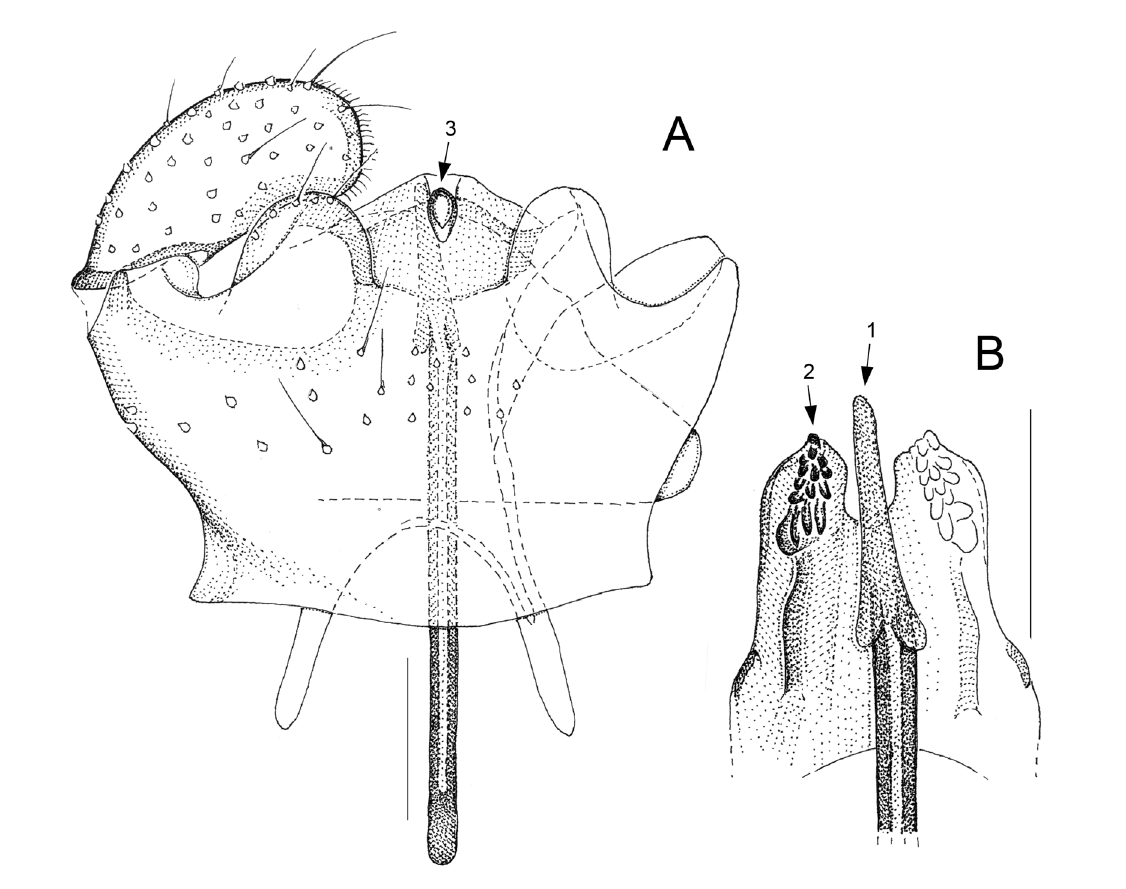
Fig. 17. Glemparon waipapa sp. nov., holotype, ♂ (NZAC, no. CEC1423). A . Genitalia, ventral. B . Apex of ejaculatory apodeme and tegmen, ventral. Scale bars = 0.05 mm. Numbered arrows indicate diagnostic characters (see